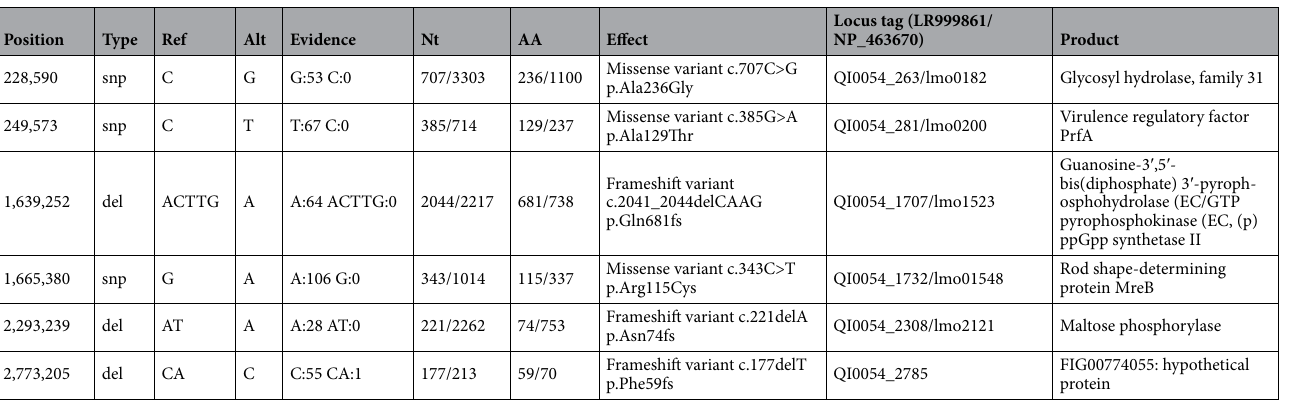
Table 2. SNP and InDels between QI0054 and QI0055 detected by snippy (v.4.2.1). The genome of QI0054 was used as reference (accession LR999861). The genome NP_463670 is commonly used as a reference L. monocytogenes genome, so the ortholog reference gene is included when applicable. Nt = nucleotide; AA = amino acid; fs = frame shift; c =